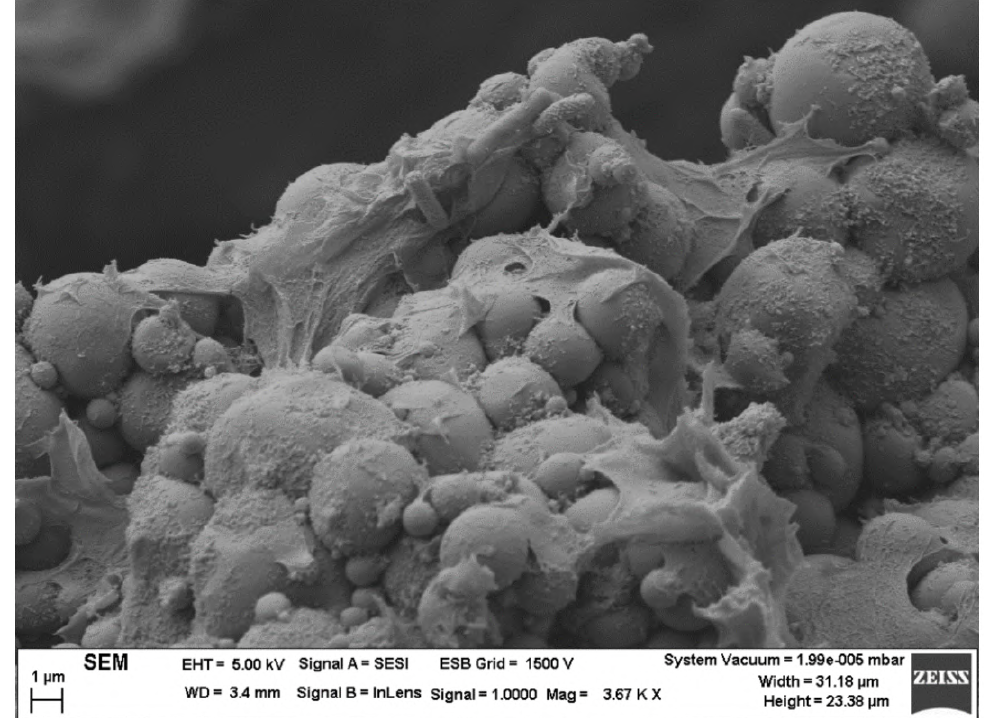
Figure 5. Representative cryo-SEM micrographs for the emulsion formulated with 0.4 wt.% of diutan